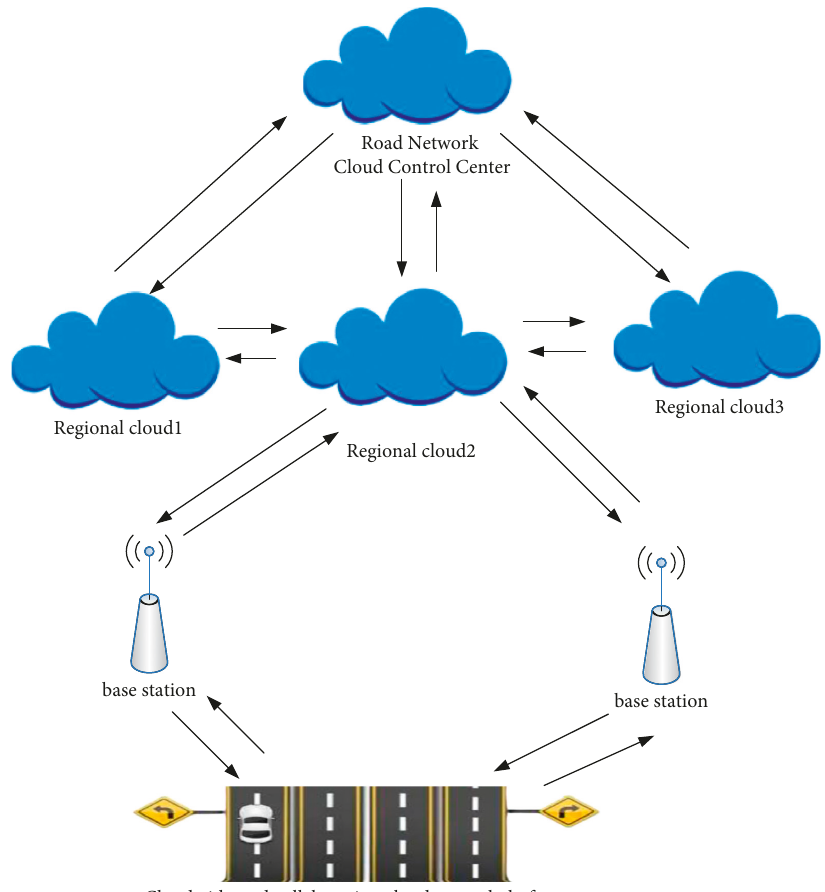
Figure 5: Structure diagram of collected traffic